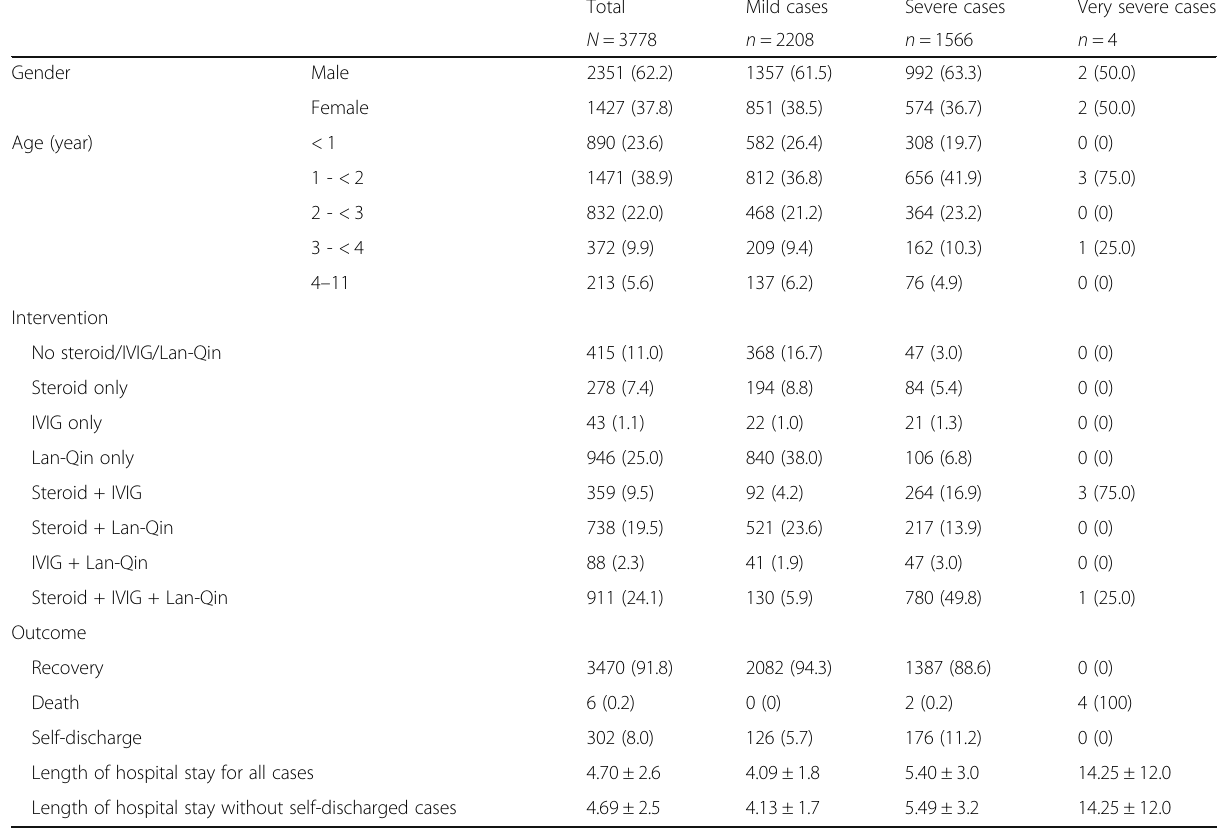
Table 1 The characteristics, intervention, and outcome of HFMD cases (2008 – 2016)